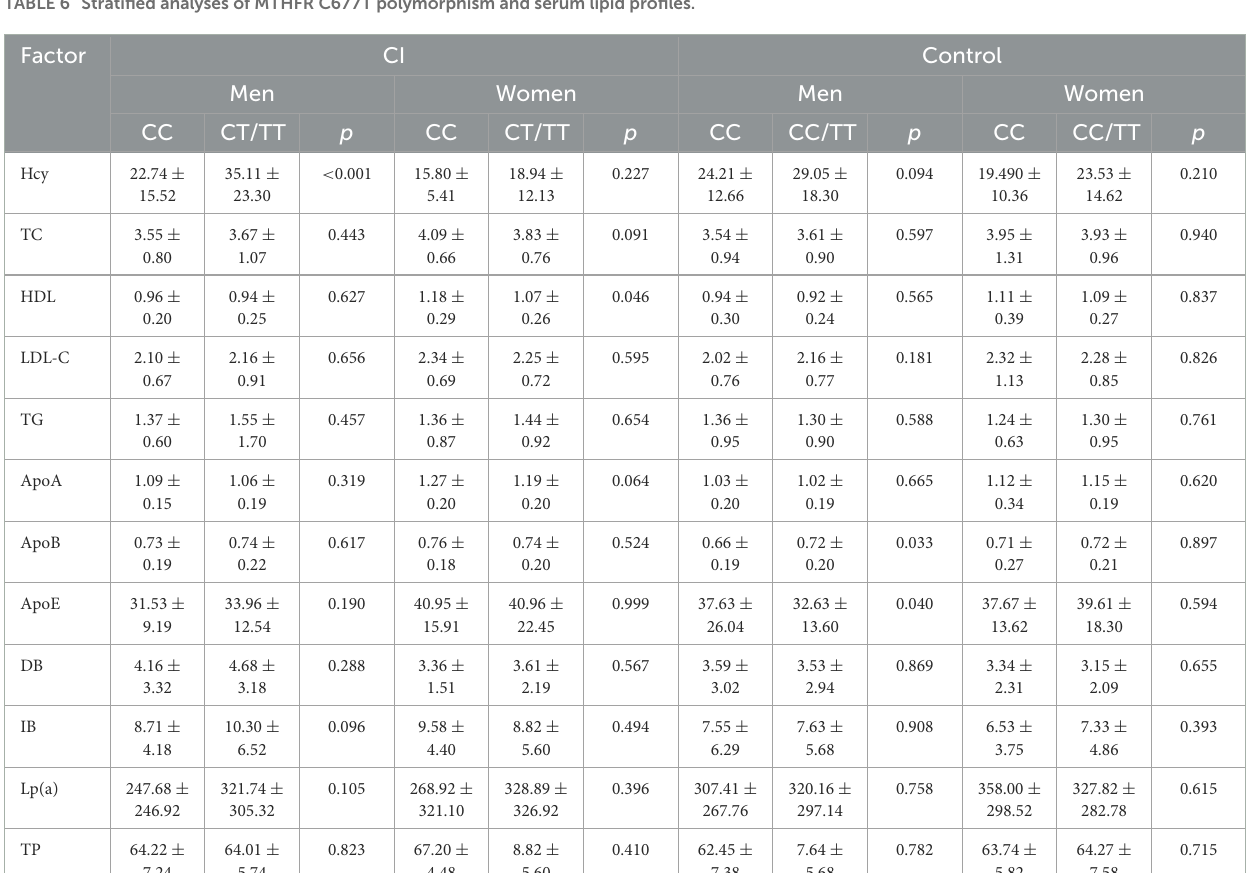
TABLE 6 Stratified analyses of MTHFR C677T polymorphism and serum lipid profiles. Factor CI Control Men Women Men